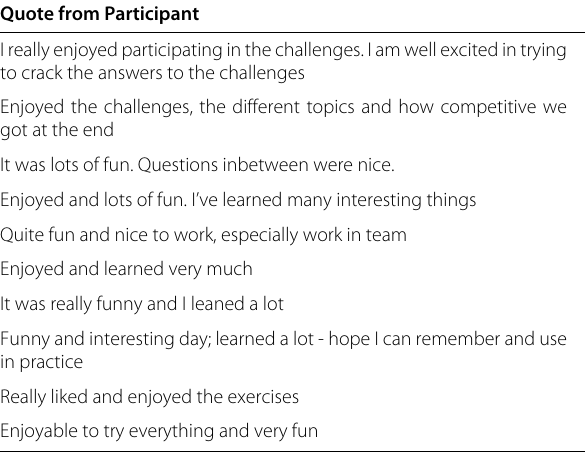
Table 7 Quotes from CSC Participants Quote from